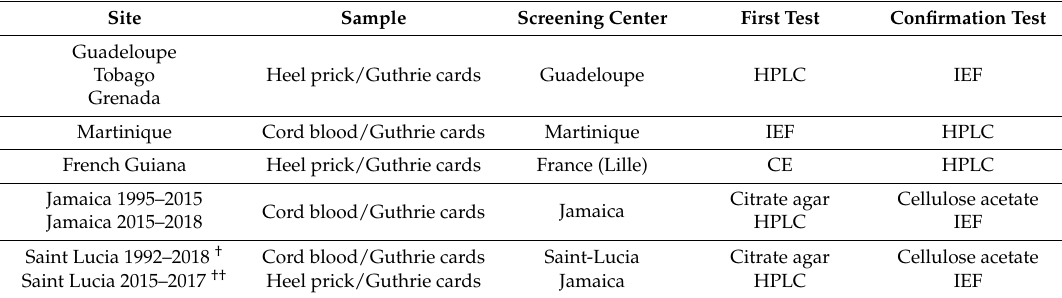
Table 1. Neonatal screening